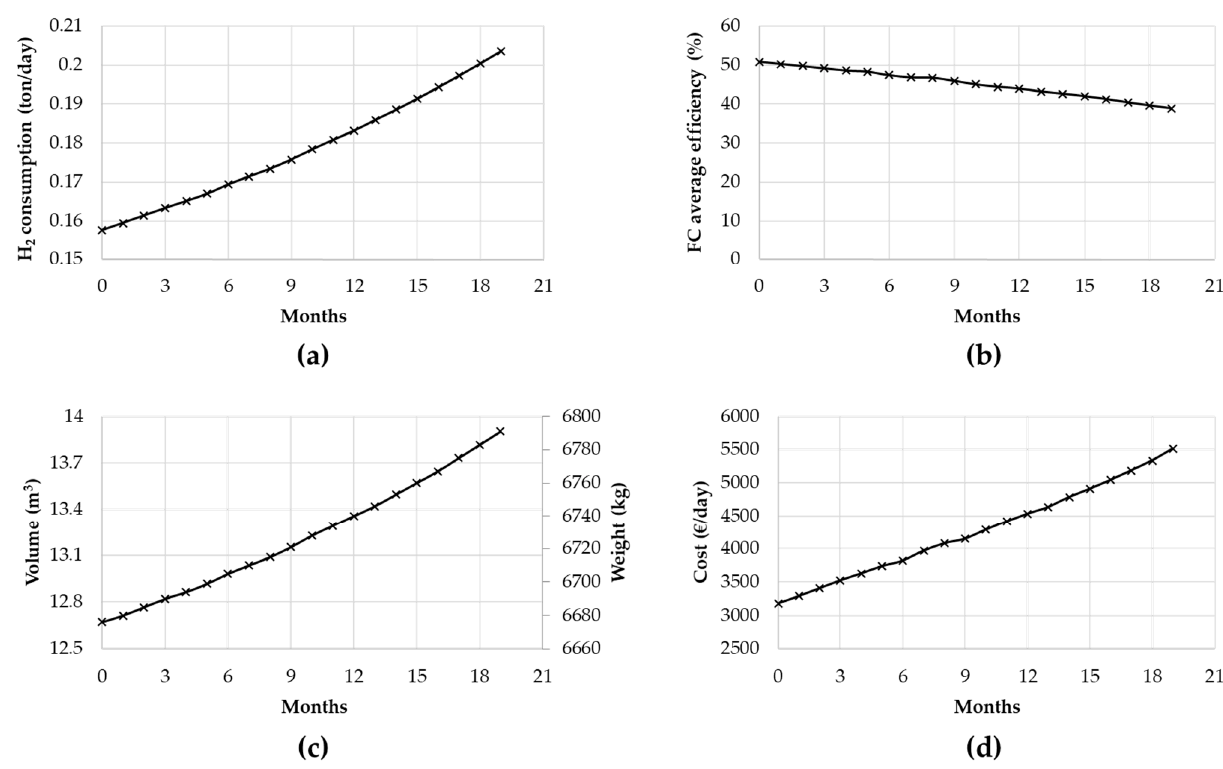
Figure 6. Energy system variables during the whole lifetime: ( a ) hydrogen daily consumption; ( b ) PEMFC average efficiency during one day; ( c ) volume and weight of the main components of the energy system; ( d ) total cost during one day of operation (value of f MO in Equation (37)).